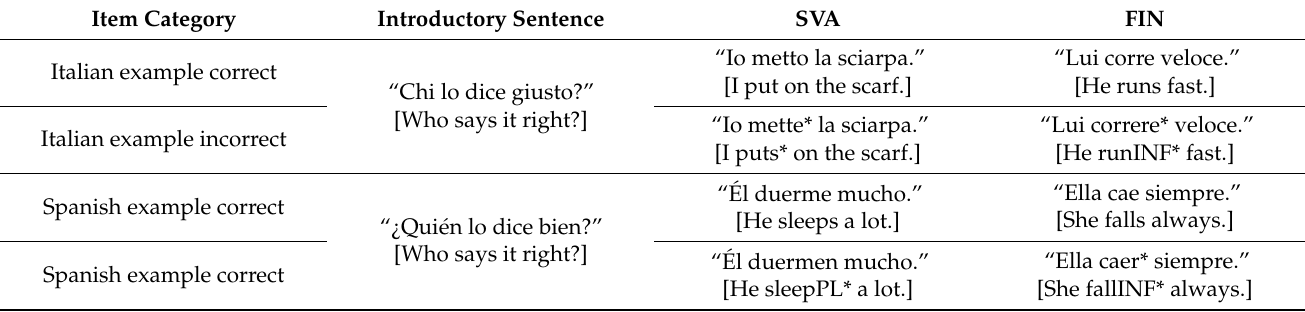
Table A3. Scoring system of children’s responses in the DNWL naming phase.